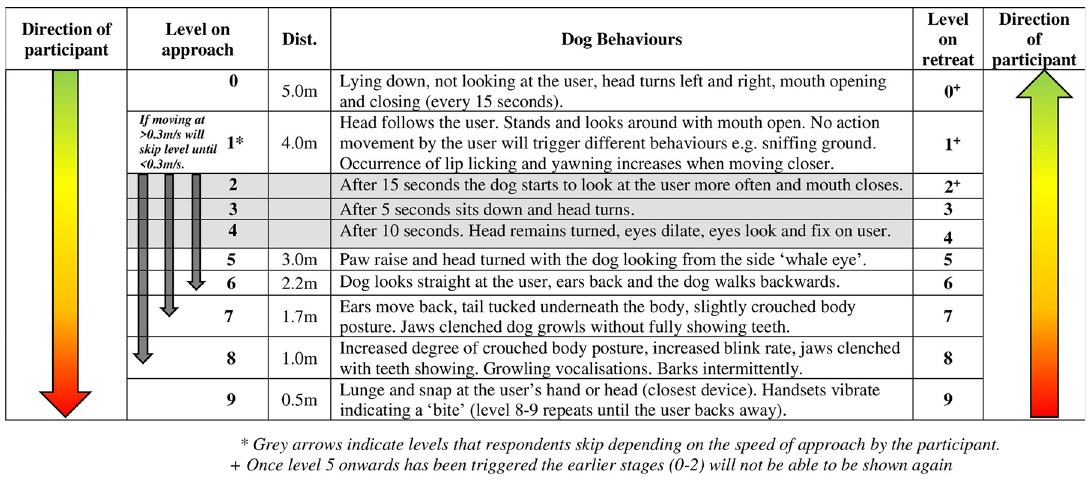
Fig 4. Levels of aggression and behaviours of the dog model (based on the Canine Ladder of Aggression